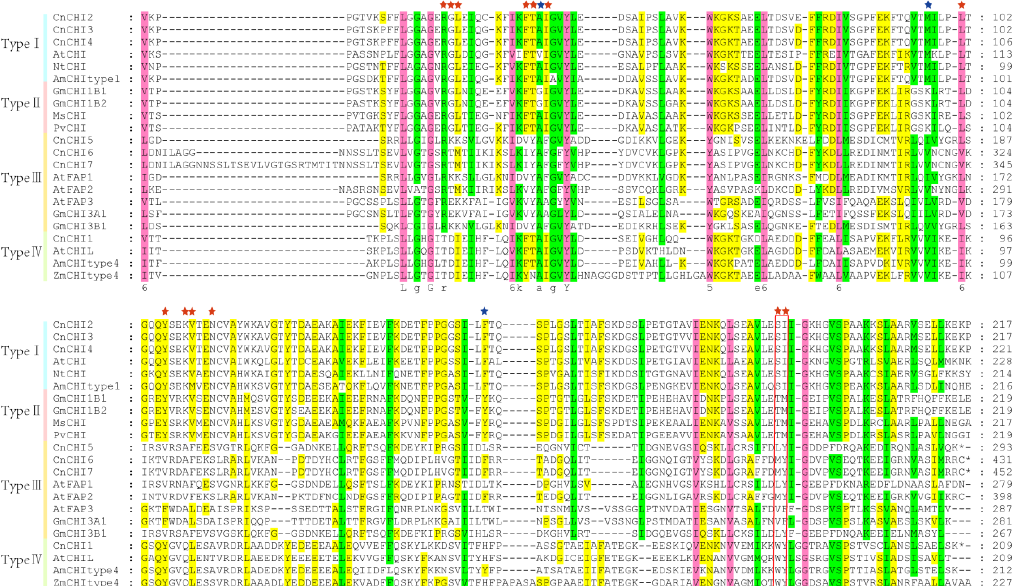
Figure 3. Multiple sequence alignment of the CHI proteins of C. nitidissima and other plant species. The red and blue asterisks represent the active site and critical catalytic residues, respectively. The residues that affect substrate preference are indicated by the red box.